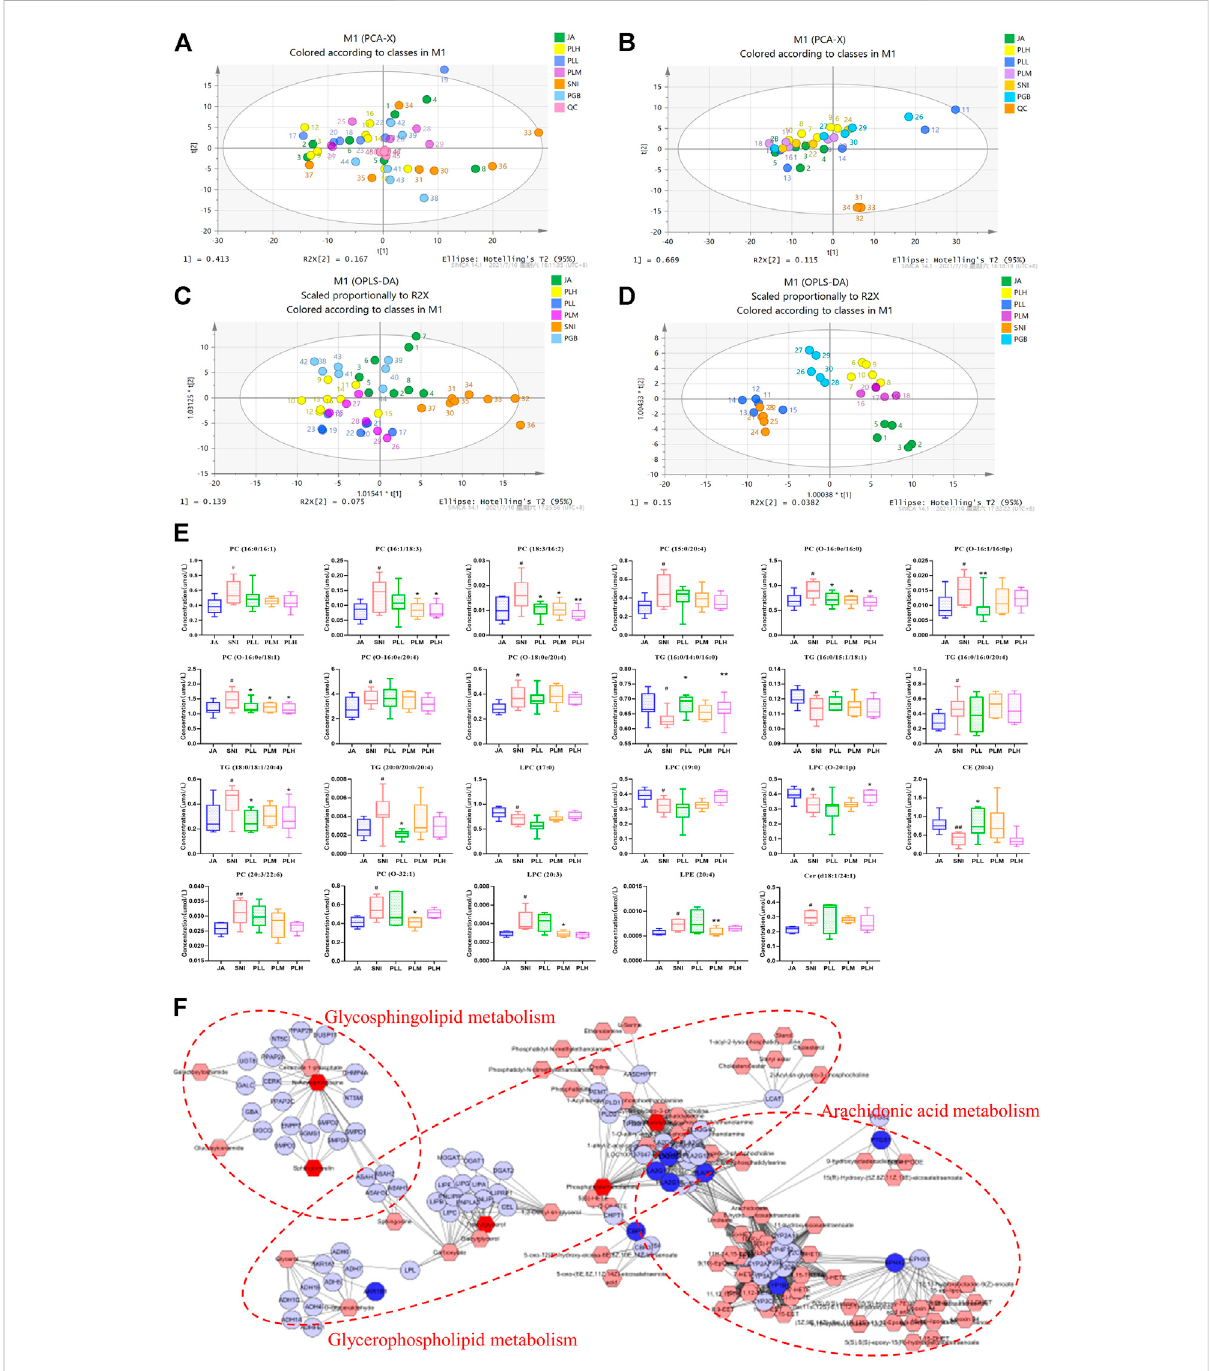
FIGURE 4 PCA plots of serum samples (A) and tissue samples (B) . OPLS-DA plots of serum samples (C) and tissue samples (D) . (E) Metabolic changes of lipids in the fi ve test groups. (F) Integrated pathway analysis of potential targets and dysregulated lipid metabolites using MetScape. JA, sham- operatedgroup; SNI,spared nerveinjurygroup, PLL,PLM,andPLL,low,middle,andhighdoseofpaeoni fl orinandliquiritincombinationgroup;PGB, pregabalin group; QC, quality